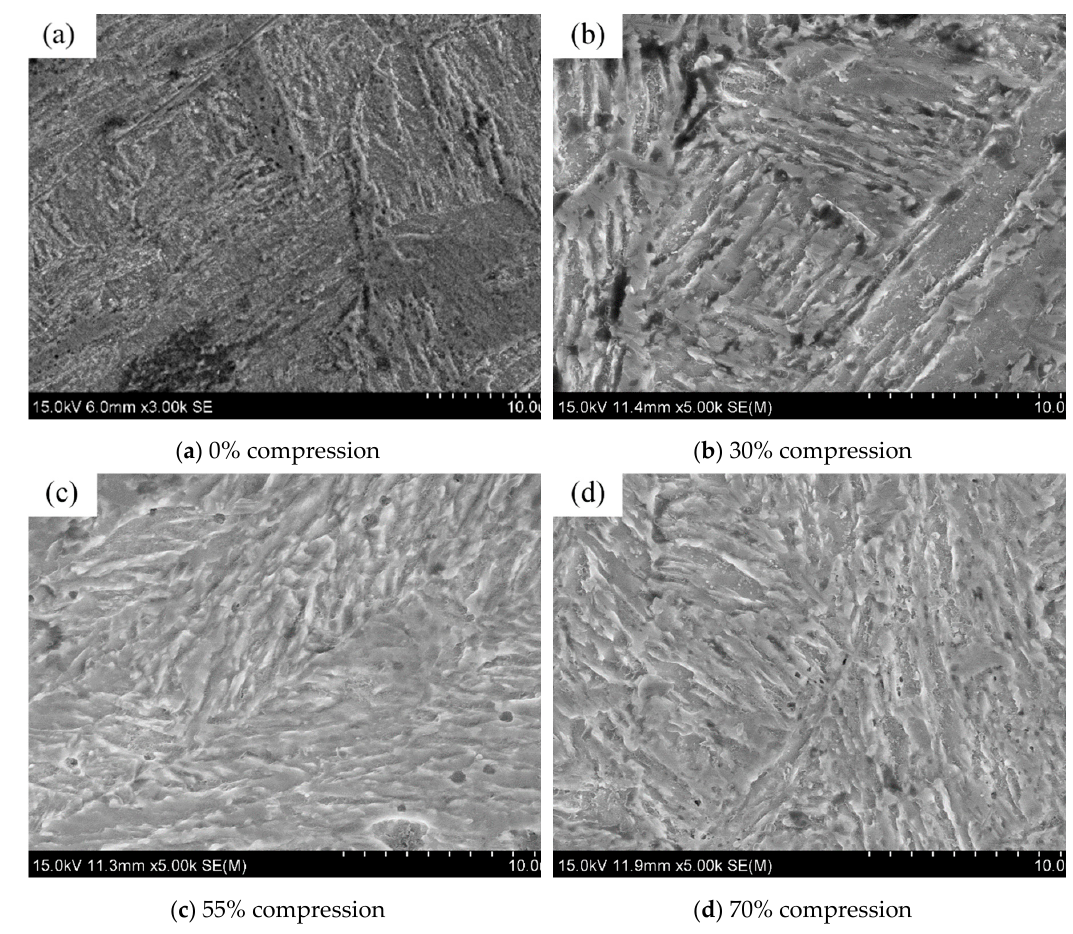
Figure 4. Scanning electron microscopy (SEM) micrographs after different degrees of deformation.